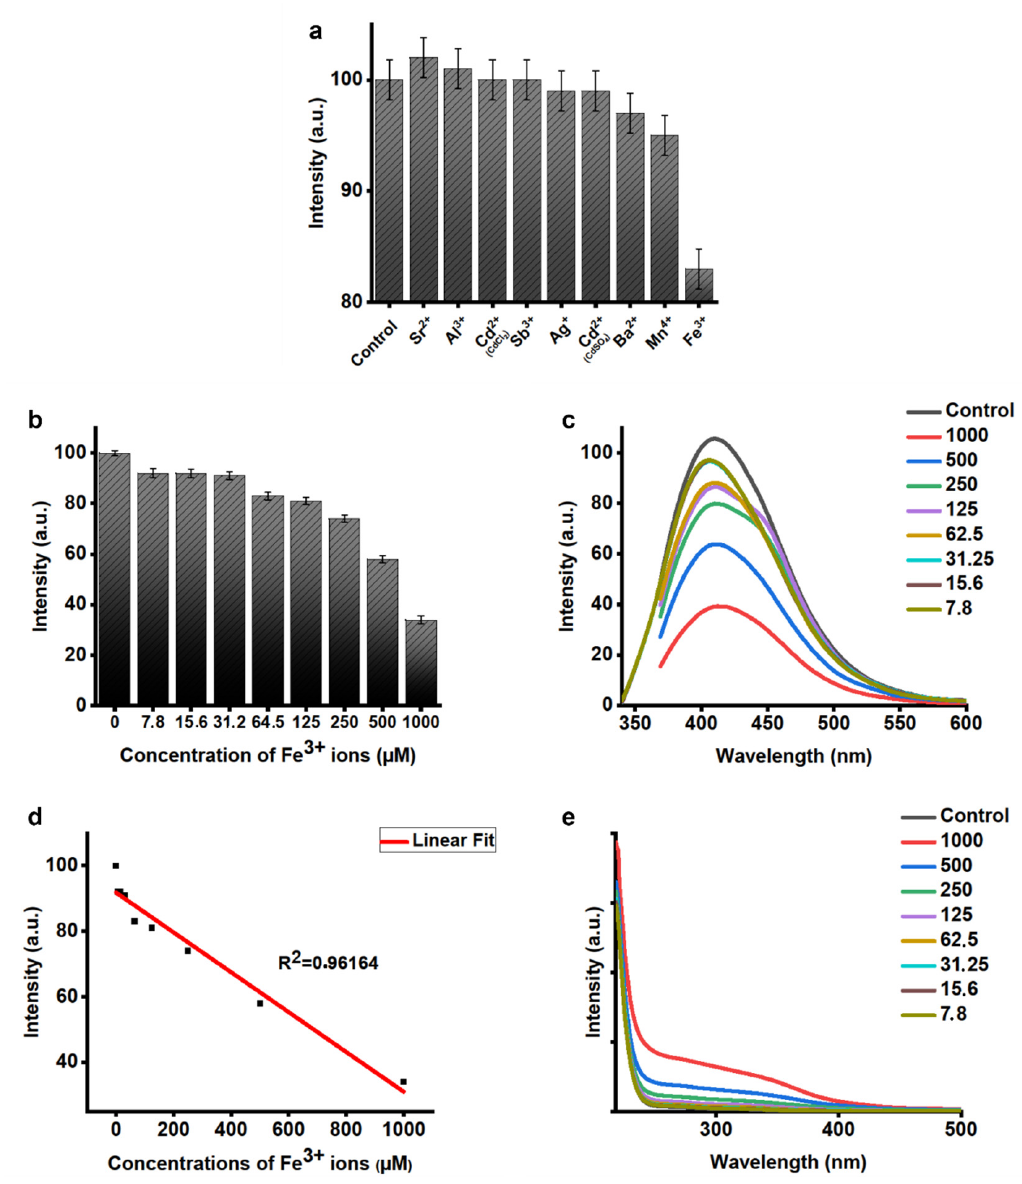
Figure 5. Fluorescence intensity of CQD suspension in the presence of 125 μ M of different metal ions ( a ). The change in PL intensity ( b ), spectra ( c ), the linear relationship between intensity and concentrations ( d ), and relevant UV-vis spectra ( e ), in the presence of Fe 3+ ions at different concentrations. The PL data were collected at ex: 320 nm. All analyses were repeated three times and average results were represented.